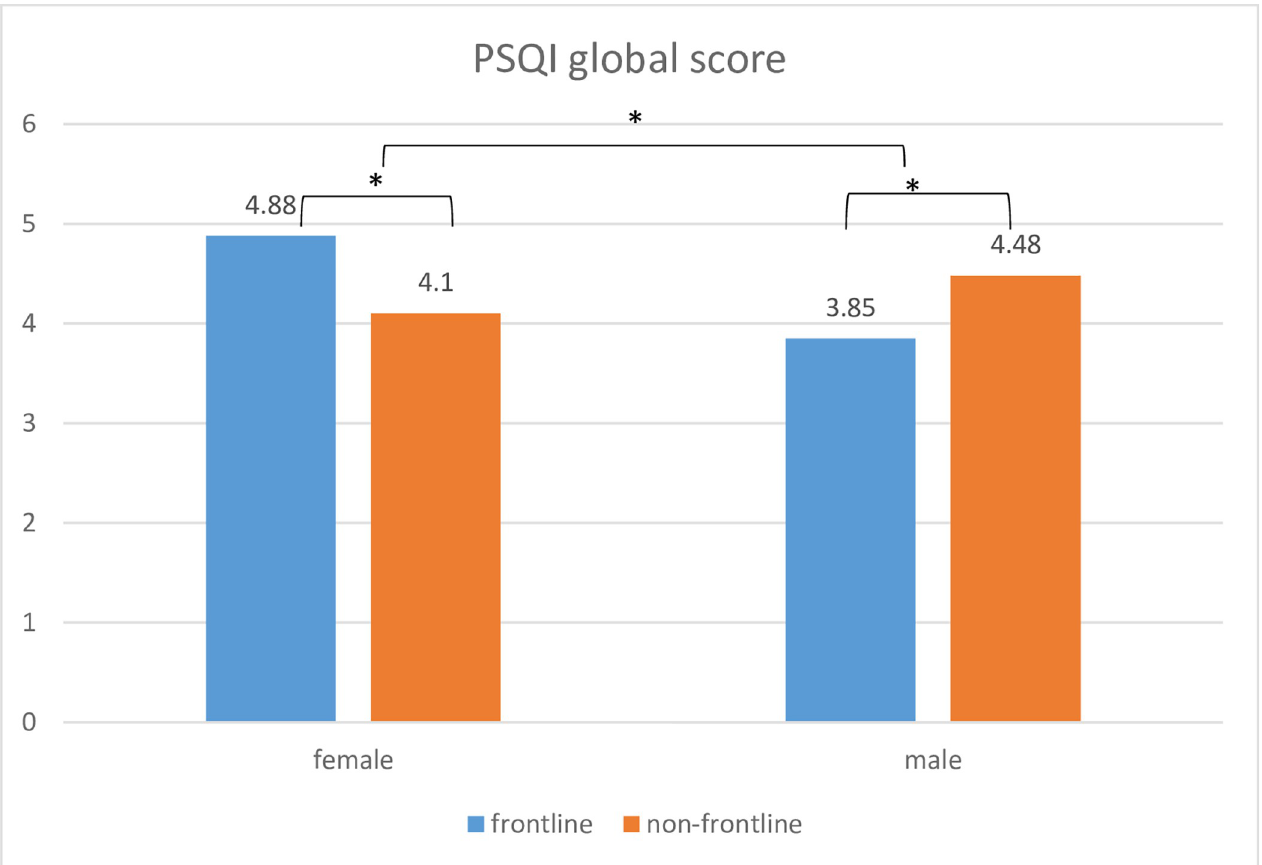
Fig 5. PSQI sum after loosened restrictions in frontline and non-fronline workers and both sexes.